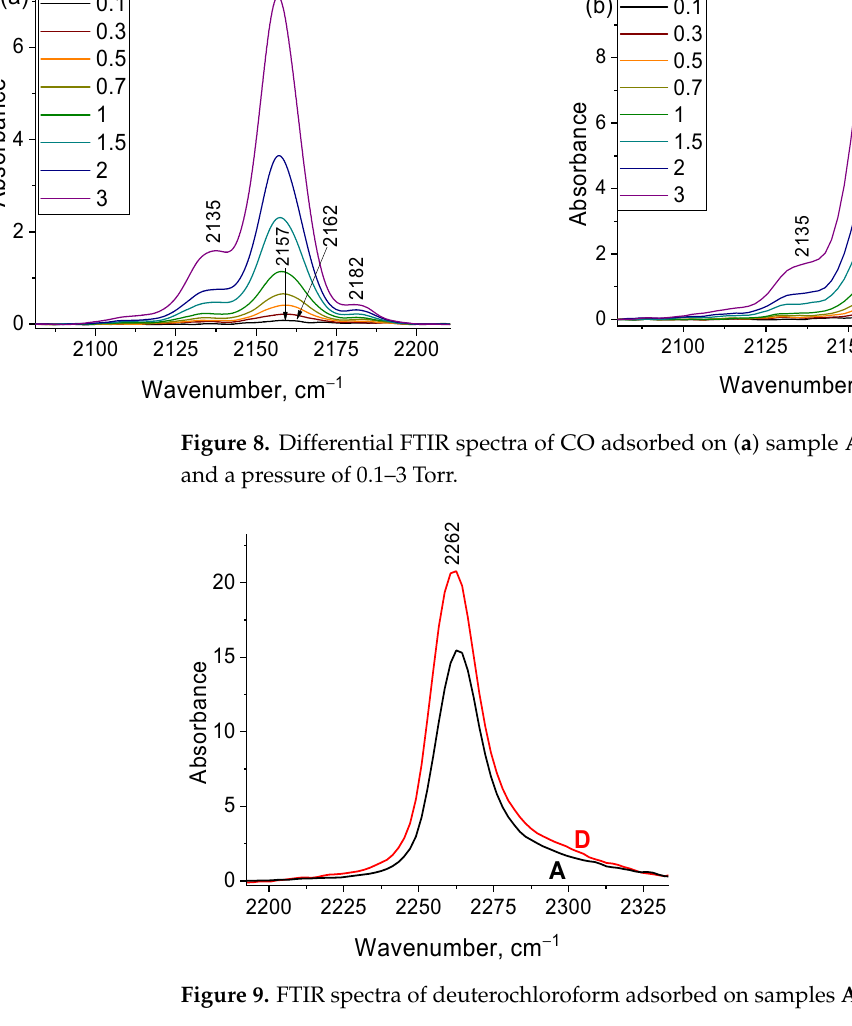
Figure 8 . Differential FTIR spectra of CO adsorbed on ( a ) sample A and ( b ) sample D at − 196 °C and a pressure of 0.1–3 Torr.